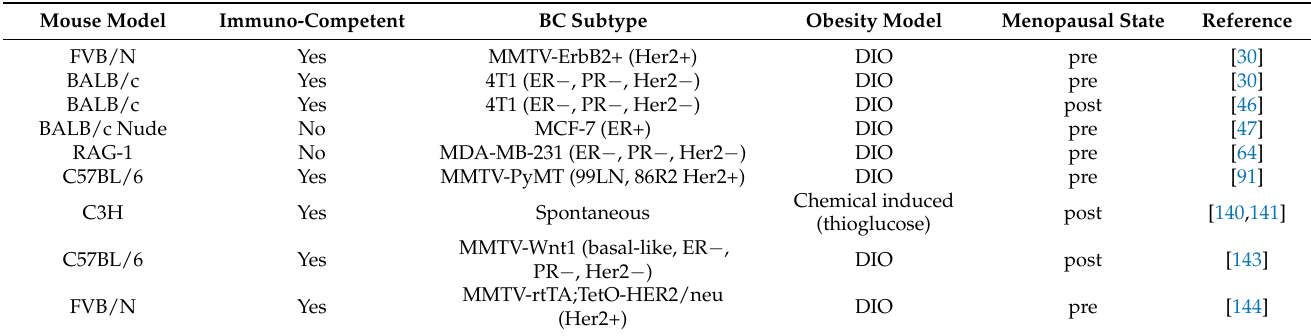
Table 1. Overview of the main features of preclinical mouse models employed to investigate the interplay between obesity and breast cancer